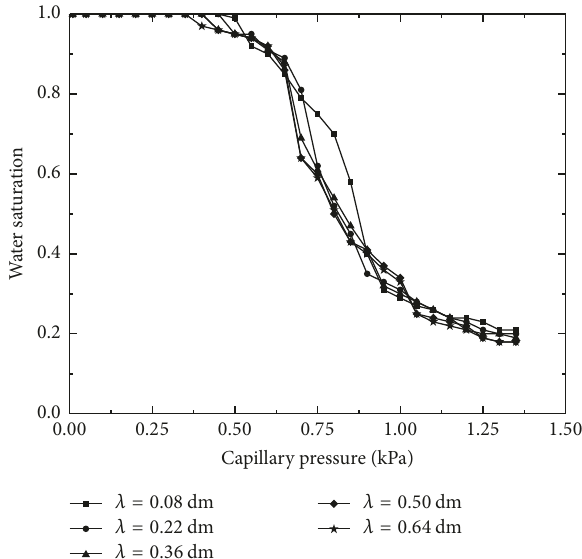
Figure 15: Capillary pressure-saturation curves for fractures with different correlation lengths.